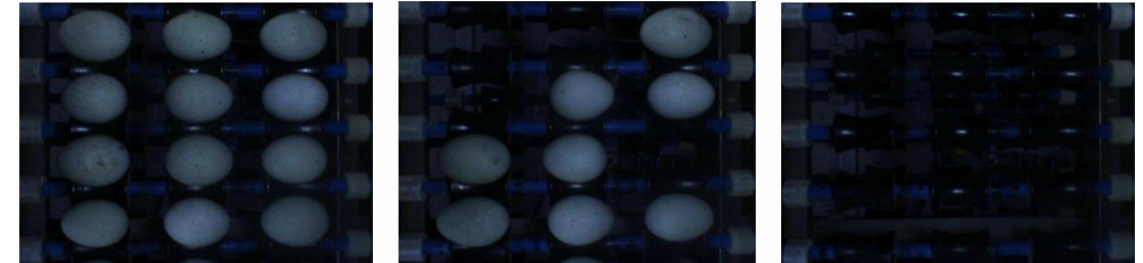
Figure 4. An image collected for preserved eggs by the online image acquisition device.